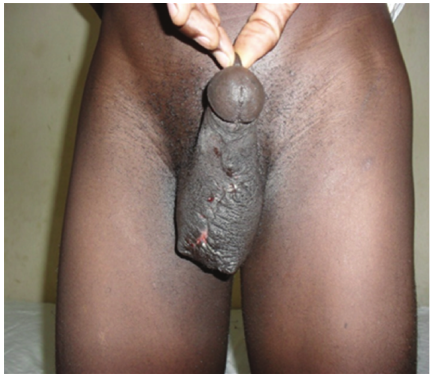
Figure 2: X-ray showing calcific scrotal nodules.